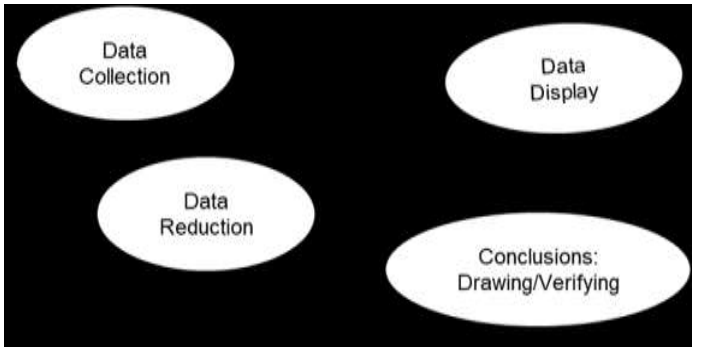
Figure 2. Qualitative Data Analysis Process (Source: Miles and Huberman, 1992)